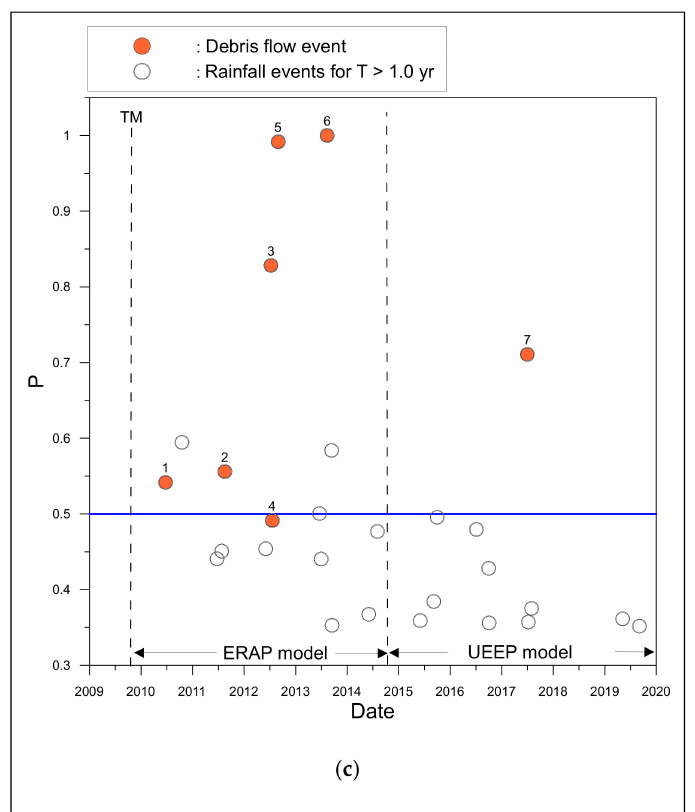
Figure 7. Probability of debris flow occurrence (P) evaluated using the model for the extreme rainfall- affected period (ERAP) within the 3 years after Typhoon Morakot (Equation (8)), and the model for the unaffected by extreme events period (UEEP) after the ERAP (Equation (9)). The rainfall return period (T in Equation (8) or ((9)) was determined using three rainfall indexes: I m , R d , or RI. ( a ) T determined by I m : six debris flows were predicted within twenty rainfall events when P ≥ 0.5 and one debris flow events with P ≥ 0.5; ( b ) T determined by R d : six debris flows were predicted within ten rainfall events when P ≥ 0.5 and one debris flow events within P ≥ 0.5; and ( c ) T determined by RI: Six debris flows were predicted within a total of eight rainfall events when P ≥ 0.5, and one debris flow event when P ≥